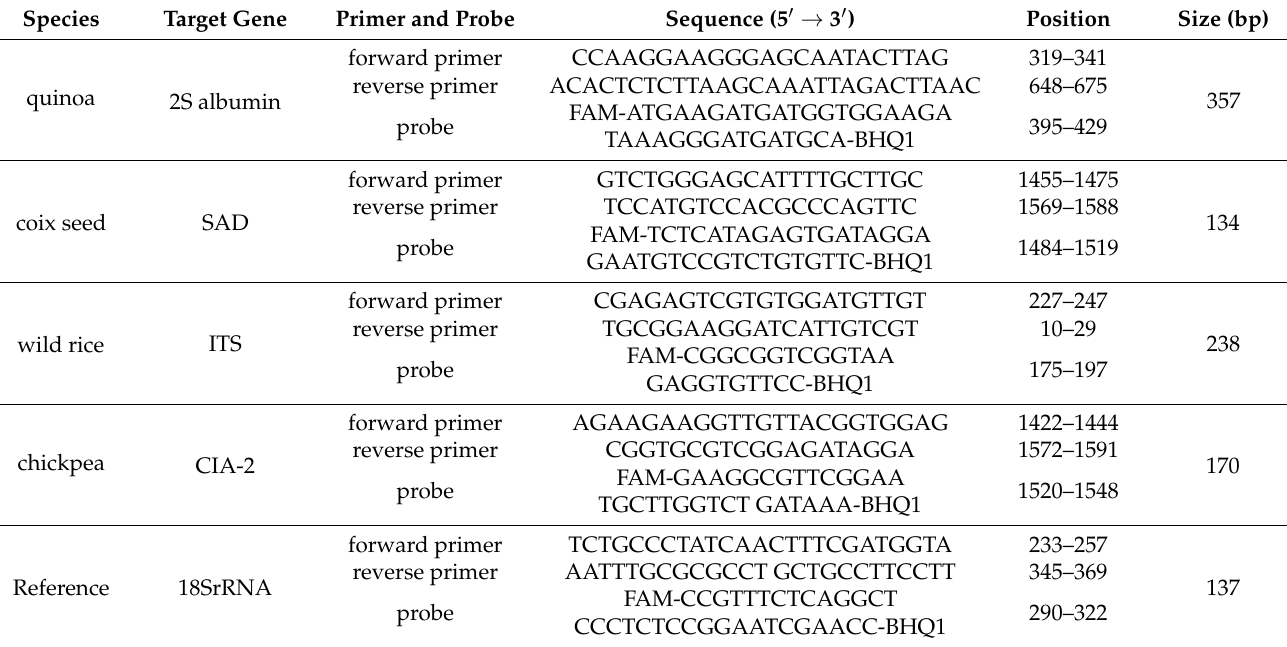
Table 1. Primers and probes sequence used in this study a